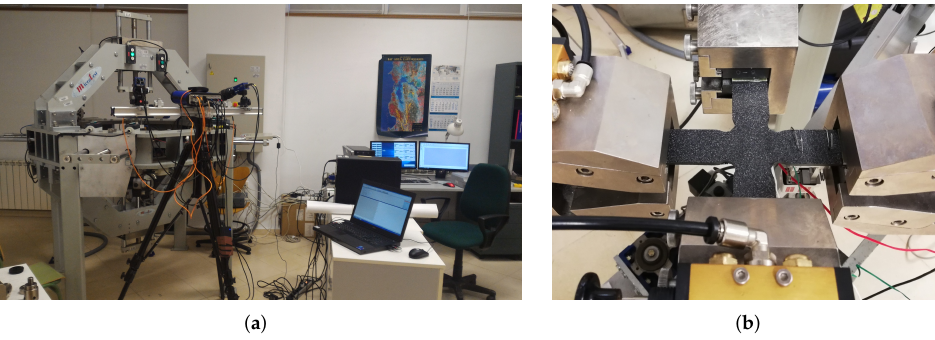
Figure 1. Triaxial testing facility at University of Castilla-La Mancha (UCLM, Spain): ( a ) triaxial testing machine. ( b ) CFRP cruciform specimen being tested under biaxial tensile–tensile